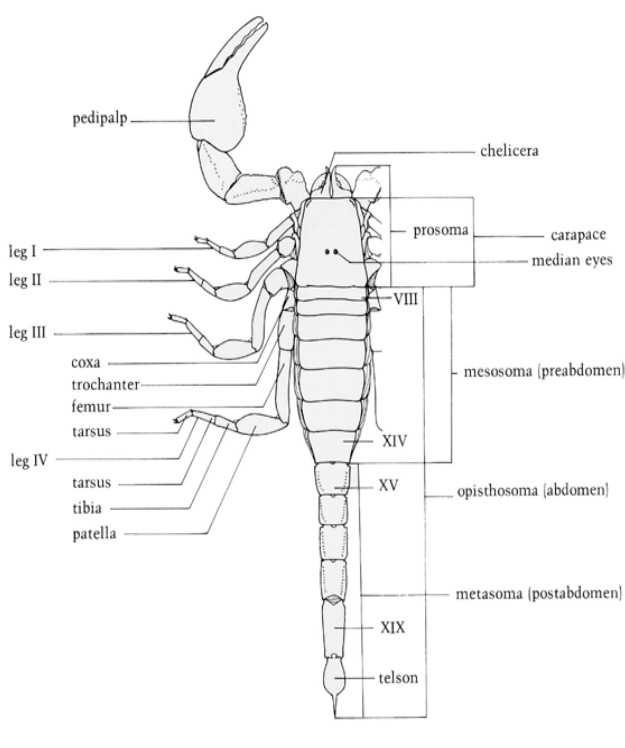
Figure 2: Scorpion dorsal view (14)